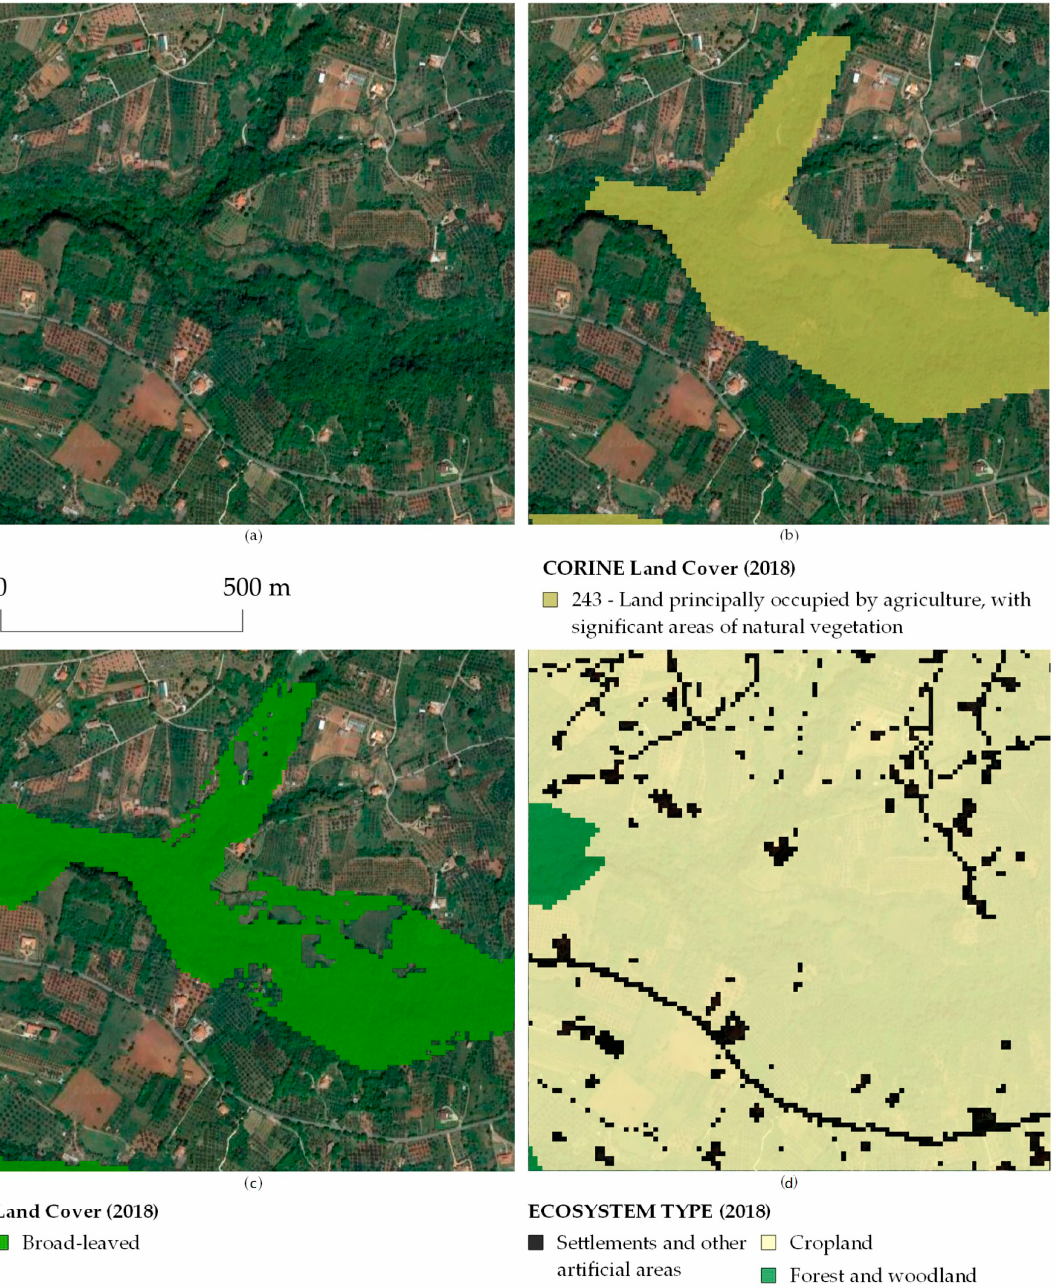
Figure 10. Examples of land cover and land use classes within the types of ecosystems. In the example there is a patch of natural vegetation surrounded by croplands ( a ). The area is classified as 243 "Land mainly occupied by agriculture, with significant areas of natural vegetation" by CLC ( b ) and corresponds to the "Cropland" MAES ecosystem typology ( d ), while in the land cover map the natural woody vegetation component the from the agricultural component ( c ) has been